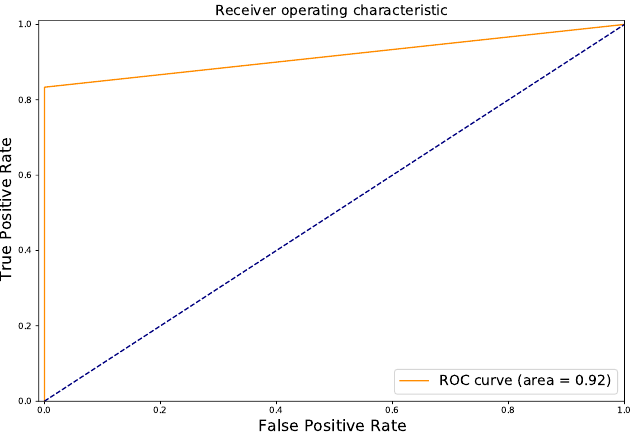
Figure 9. ROC curve of the proposed